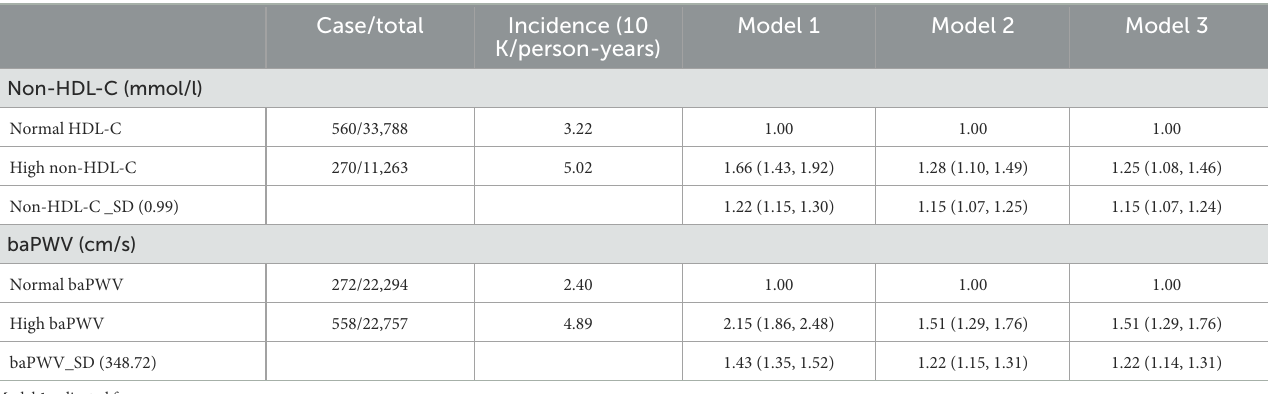
TABLE 2 Influence of serum non-HDL-C or baPWV on